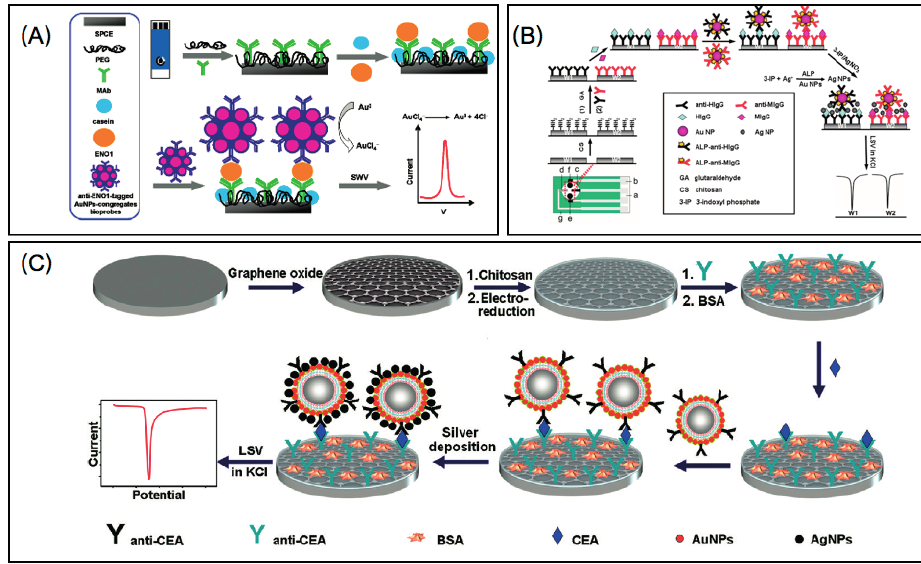
Figure 1. Schematic representation of ( A ) the operation of the electrochemical immunosensor for the detection of ENO1 [37]. Reprinted with permission from (Ho, J.A.A.; Chang,